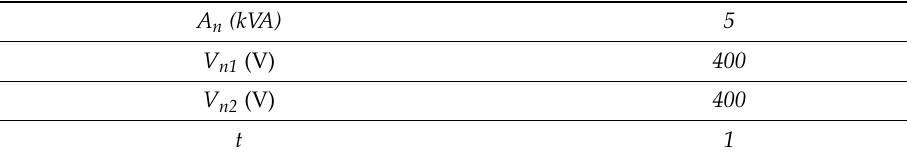
Table 5. Three-phase transformer.